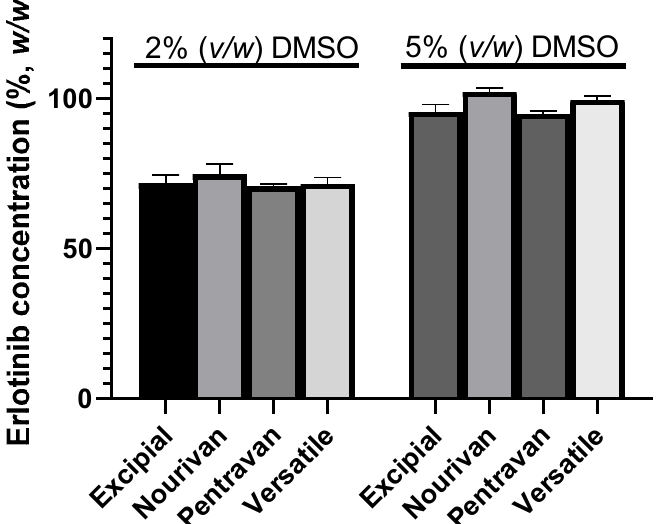
Figure 2. Erlotinib concentration (%, w / w ) after one month of storage at ambient temperature and as a function of the volume of the extract of DMSO and of the four ready-to-use cream vehicles: Excipial ® , Nourivan Antiox ® , Pentravan ® , Versatile ® . Three extracts were obtained for each condition, and each extract was analyzed once.